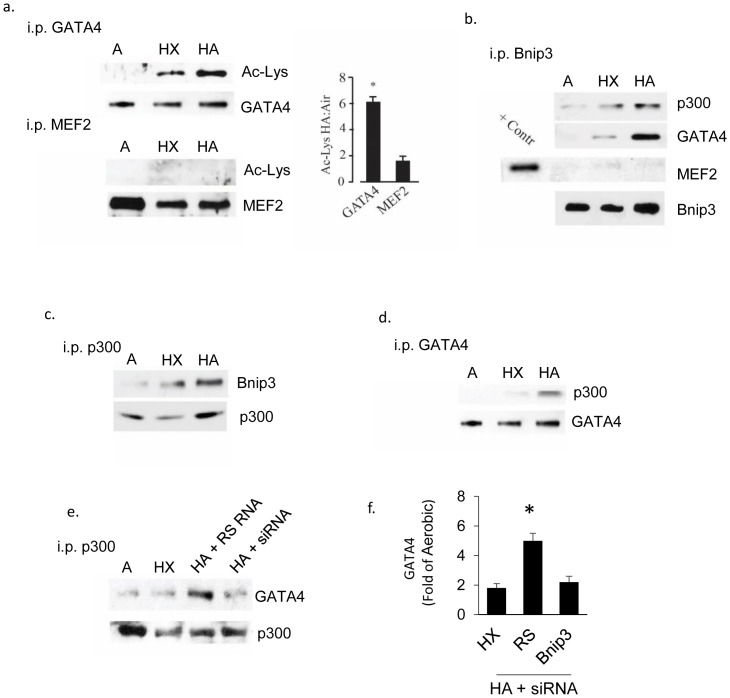
Bnip3 binds GATA4 and p300.GATA4 and MEF2 were immunoprecipitated from cardiac myocytes exposed to aerobic (A), hypoxia (HX) or hypoxia-acidosis (HA) as indicated and the acetylation level of each protein determined by western blot analysis (A). Western blot quantitation of changes in GATA4 and MEF2 acetylation levels in hypoxic-acidotic cardiac myocytes is shown to the right. In (B-D), Bnip3, GATA4 and p300 were immunoprecipitated from cardiac myocytes exposed aerobic (A), hypoxia (HX), or hypoxia-acidosis (HA). Precipitated proteins were detected by western blot analysis using antibodies directed against the indicated proteins. In (E) p300 was immunoprecipitated from cardiac myocytes treated with either random sequence siRNA (RS RNA) or Bnip3 specific siRNA (siRNA) and the western blot probed for GATA4. Western blot quantitation of immunoprecipitated GATA4 is shown to the right (F). Results are mean ± S.E.M., * significantly different then controls (p < 0.05), n = 3.